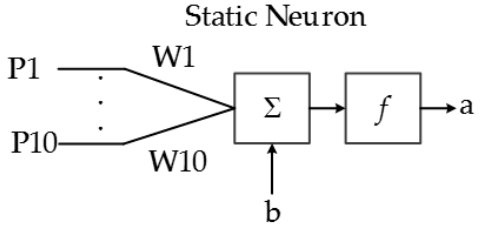
Figure 14. Implemented static neuron architecture.